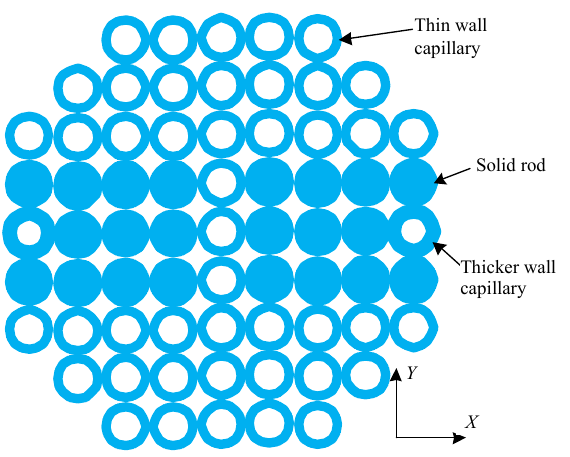
Fig. 2 Stacked preform of the proposed PCF in the x - y plane.